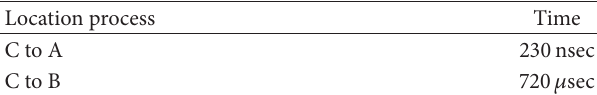
Table 4: Time consumed during location